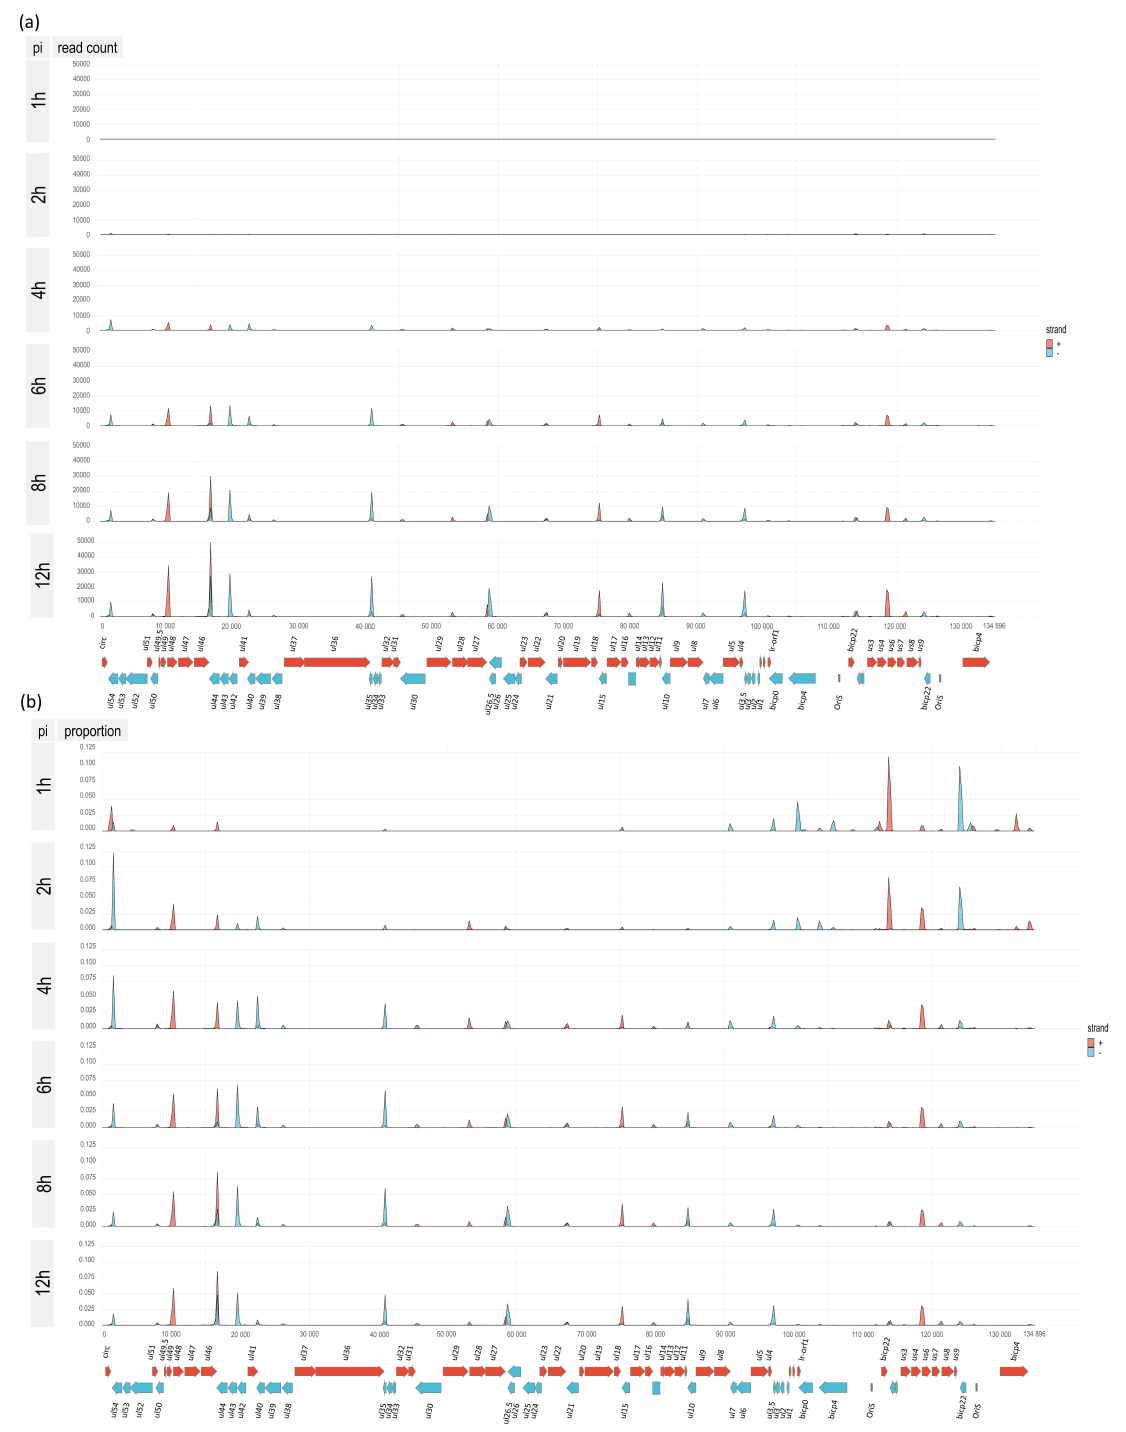
Figure 8. Genome-wide expression of transcription end sites. This figure shows the TES distribution along the viral genome in a time-varying manner using a density plot. ( a ) The Y -axis shows the number of TESs using the same scales. Red color indicates left-to-right orientation of the TESs, whereas blue color indicates the opposite orientation of the TESs. ( b ) This panel shows the proportion of the TESs within the total pool of TESs. Due to the use of common poly(A) signal by the members of tandem gene clusters, in most cases, we are unable to correspond the TSSs and the